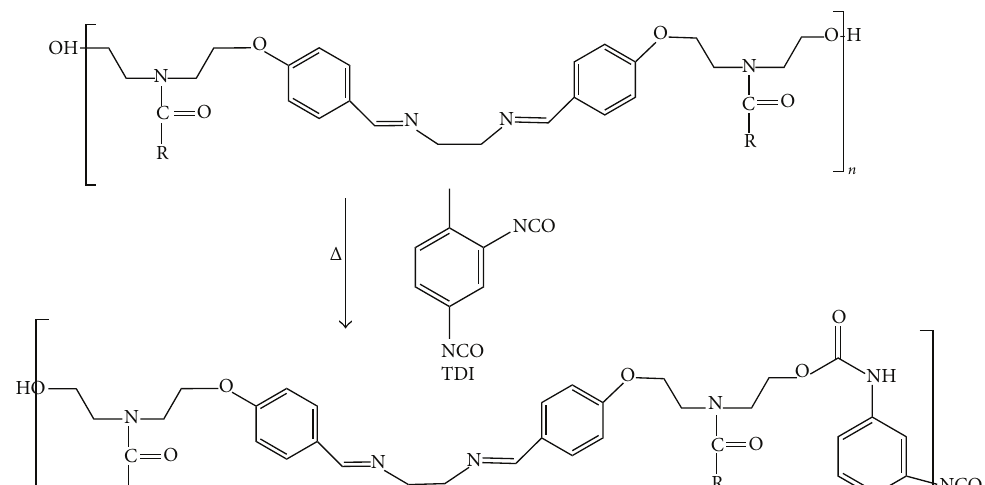
Scheme 2: Synthesis of PEAF.